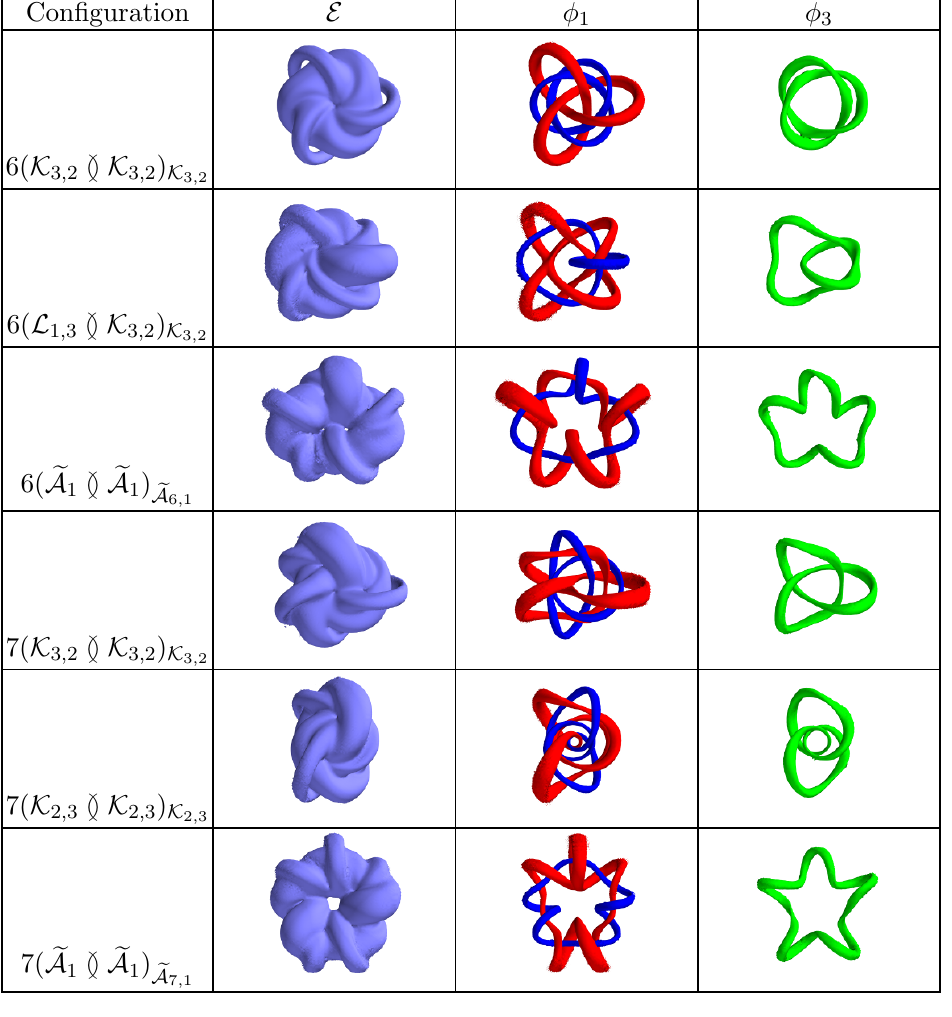
Table 2 . E = 15 isosurfaces and the isosurfaces of the (cid:12)eld components (cid:30) 1 = (cid:6) 0 : 9 and (cid:30) 3 = (cid:0) 0 : 9 for Q = 1 (cid:0) 7 Hop(cid:12)ons in the model (2.1) with c 2 = 0 : 5 ; c 4 = 1 ; m = 4 and the potential V = m 2 ( (cid:30) 1 (cid:0) 1 = 3) 2